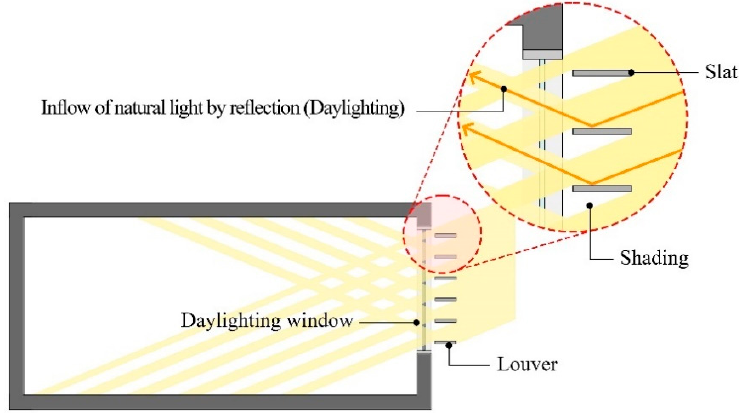
Figure 1. Shading and daylighting by a louver .